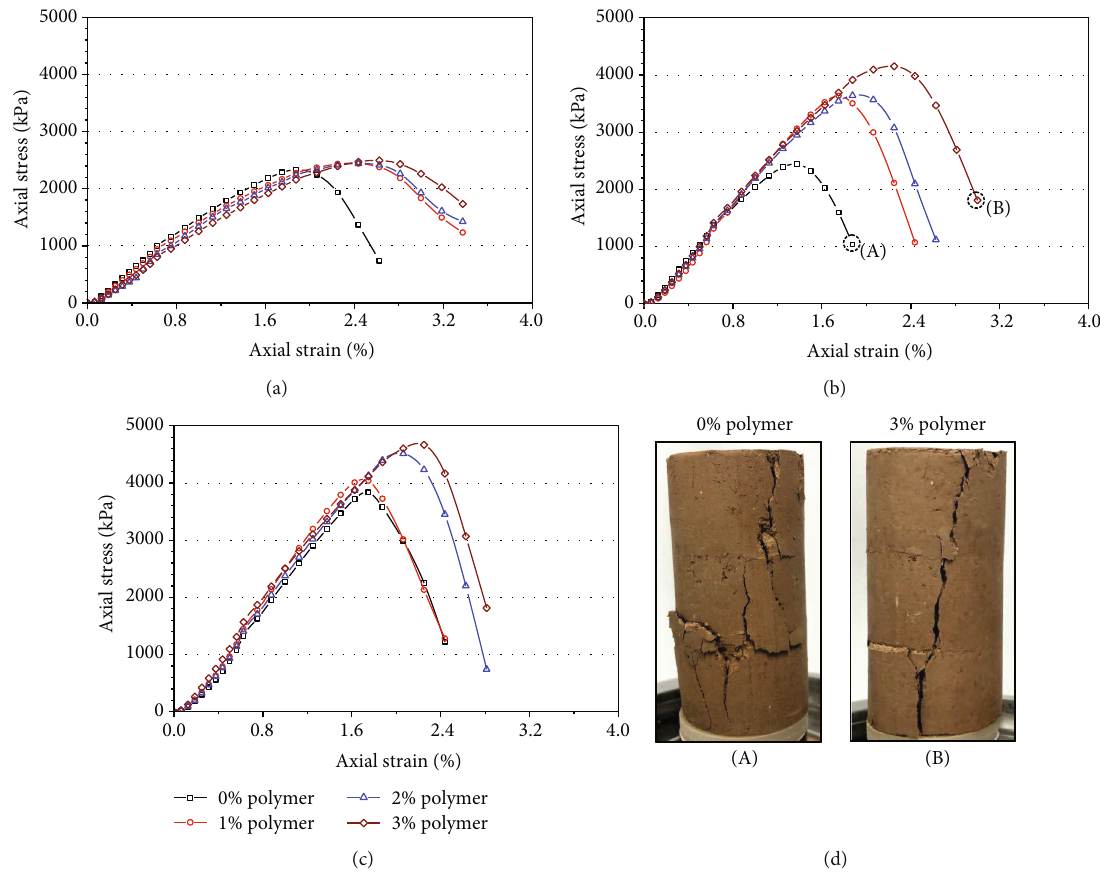
Figure 4: Typical stress-strain curves of the specimens in room condition after (a) 1-day curing, (b) 3-day curing, and (c) 9-day curing. And (d) failure patterns of the specimens treated by 0% and 3% polymer after 3 days of